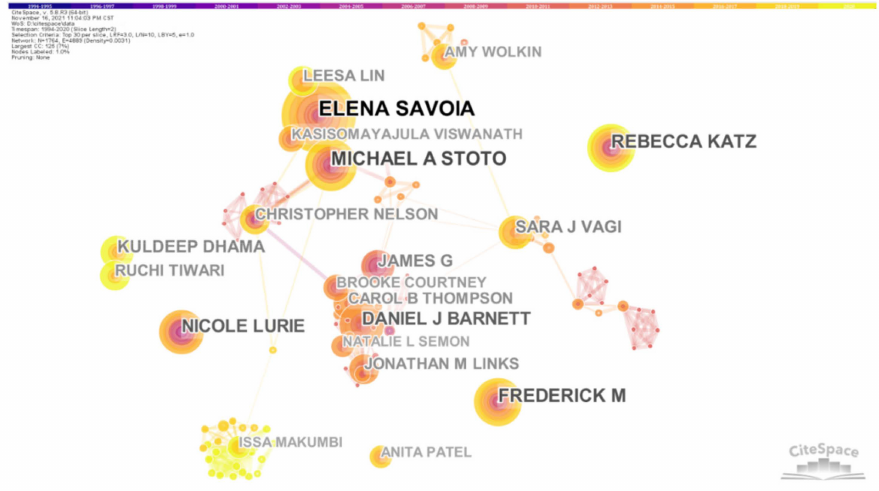
Figure 2. Co-authorship network (1994–2020). Each node corresponds to an author. The larger size of the node, the more papers the author has collaborated to publish. The thicker the line between the nodes, the closer the two authors work